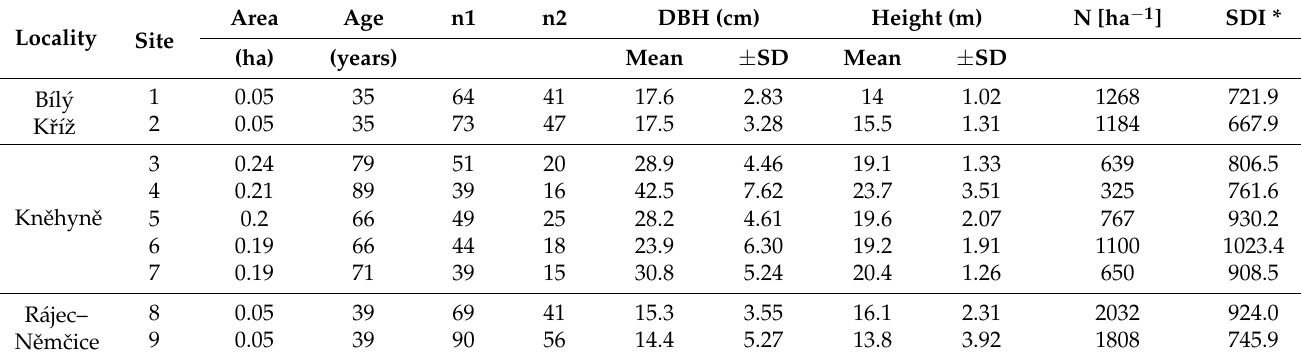
Table 1. Site characteristics used for evaluating social area shape, n1 represents the number of trees growing in the study site, n2 the number of trees used for computing tree social area, N—number of trees per hectare, SDI—stand density index. Locality